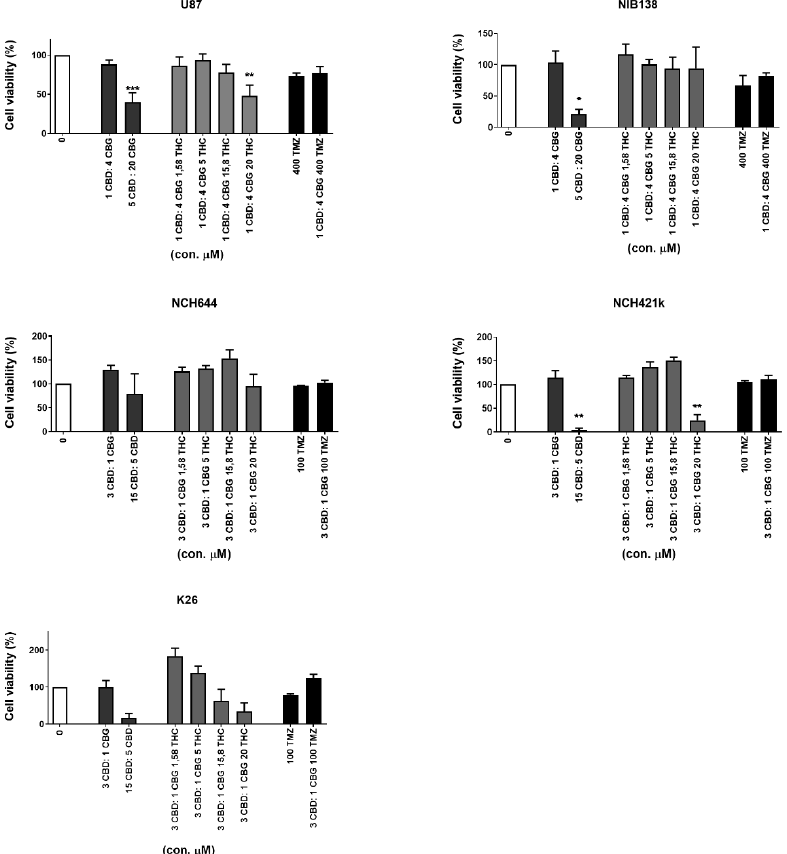
Figure 6. The effects of combined CBD, CBG, THC, and TMZ on the viability of GB cells and GSCs. The GB cell line U87, patient-derived cell lines NIB138 and NCH421k, and GSC lines NCH644 and K26 were exposed to optimized CBD:CBG combinations (see Figure 5) to which increasing THC and two selected TMZ concentrations were added, based on the results of Thorres et al. [24], and treated for 48 h. Light grey bars represent combinations of CBG and CBD with THC, black bars represent TMZ treatment alone or in combination with CBD:CBG, and white bars represent vehicle-treated controls to which all the data are normalized. Error bars represent mean ± S.E.M. Statistical analyses were performed using GraphPad Prism software, using one-way ANOVA (* p < 0.05, ** p < 0.01, and *** p < 0.001). Three biological and three technical repeats were performed. Vehicle comprised ≤ 0.4% ( v / v ) DMSO for CBD and 0.24% ( v / v ) ethanol for CBG. Similar results were demonstrated for the GSC lines NCH644 and NCH421k at the CBD:CBG ratio of 3:1, which most efficient inhibited cell viability. The addition of THC to subtoxic CBD:CBG concentrations had no efficacy. At or above 15 μM:5 μM of CBD:CBG ratio, GSC cell viability was sufficiently inhibited in all three GSC lines (see the third col- umn from the left in each graph, Figure 6), most prominently in the NCH421k cell line,